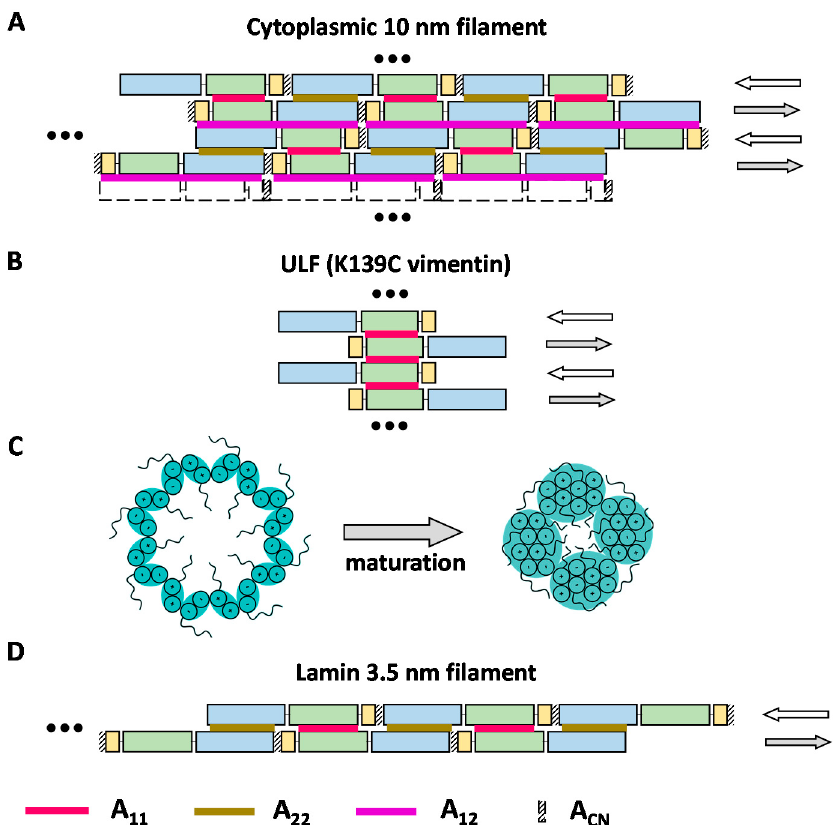
Figure 3. Proposed models of the IF structure. Coil1A, coil1B, and coil2 are schematically shown as yellow, green, and blue rectangles, respectively. Red, brown, and purple lines indicate A 11 , A 22 , and A 12 contacts respectively. The A CN contact between the C- and N-terminal ends of the rod domain is shown with diagonal stripes. ( A ) ‘Lattice-type’ model of dimer–dimer association within a cytoplasmic IF proposed by Steinert and colleagues. ( B ) Association of dimers into a ULF. ( C ) Possible maturation of the filament architecture viewed in the cross-section. The initial association of 16 dimers per cross-section eventually yields a more compact arrangement composed of four octameric protofilaments. Plus and minus signs denote the orientation of individual α -helices [77]. ( D ) Model of the lamin 3.5 nm filament containing two antiparallel threads of head-to-tail dimers.